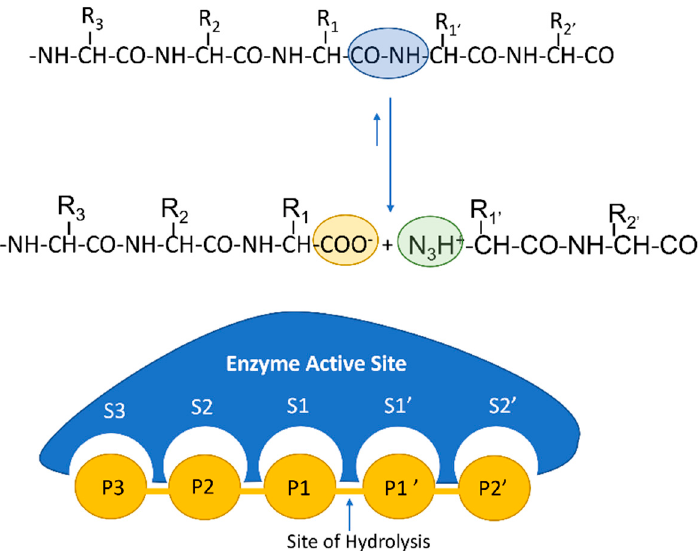
Figure 1. Graphic representation of the proteolytic degradation (hydrolysis) of a protein by the action of a protease. The enzymatic molecule contains an active site that cleaves the peptidic bond between two amino acids and involves several subsites (represented as semicircles and labeled S1–3 and S1’–2’) that allow for interaction between the enzyme and a specific sequence within the substrate, thus facilitating recognition of the peptidic bond that is to be cleaved. Hydrolysis results in two new peptides (diagram based on the publication by Baker and Numata, 2013). Table 1. Relevant bioactive peptides obtained from bovine milk caseins by the action of microbial proteases a